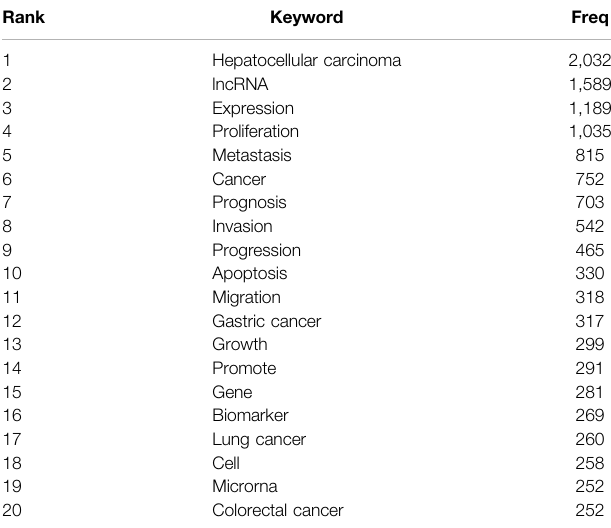
TABLE 4 | Highly frequent Terms on the roles of lncRNAs in HCC development research.